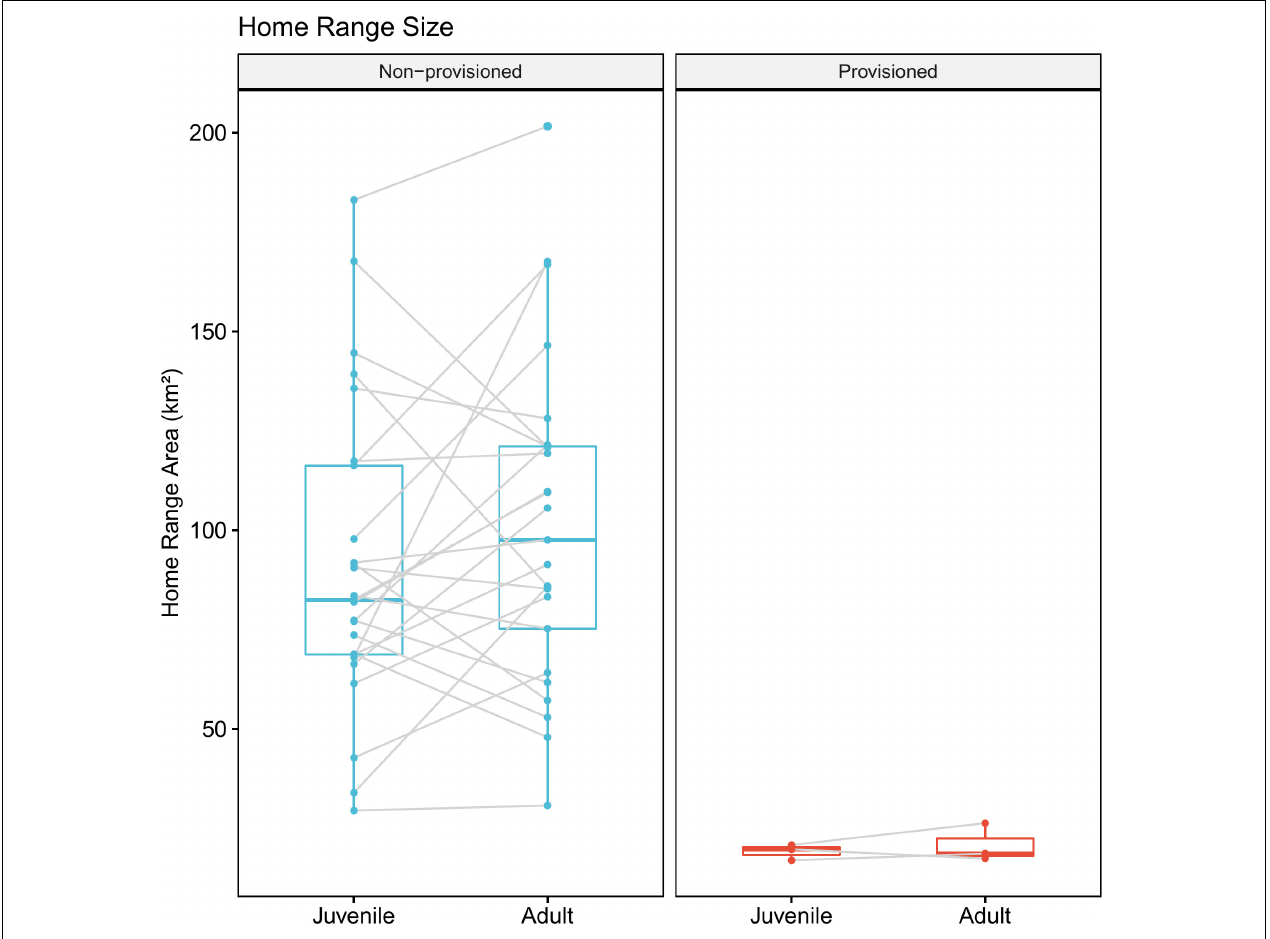
FIGURE 4 | Change in home range size across life history stage for non-provisioned ( n = 25) and provisioned ( n = 3) females in our study site. Non-provisioned females on average increased their home range sizes by about 9.8 km 2 from the juvenile to adult period, though this was not a significant effect ( Z = 1.367, p -value =